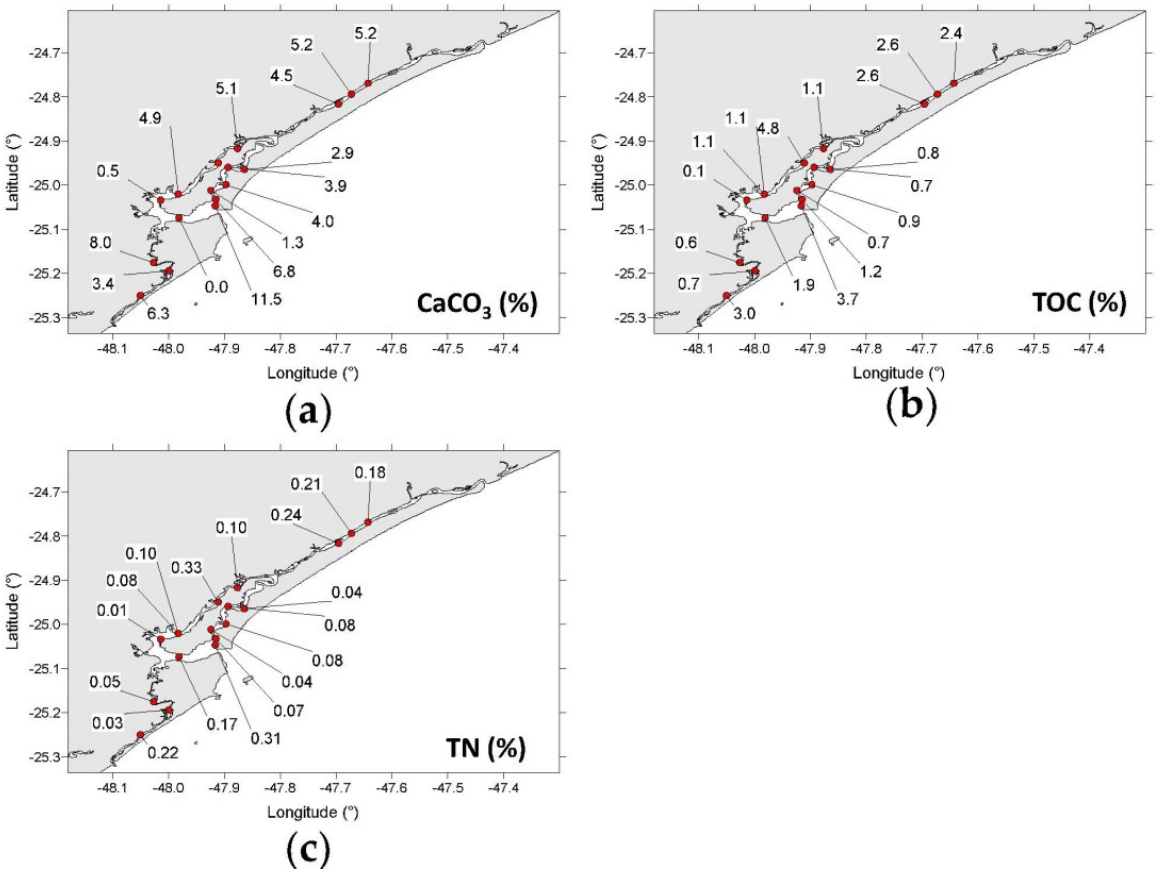
Figure 3. Spatial distribution of: ( a ) Calcium carbonate (%); ( b ) Total Organic Carbon (%); ( c ) Total Nitrogen (%).